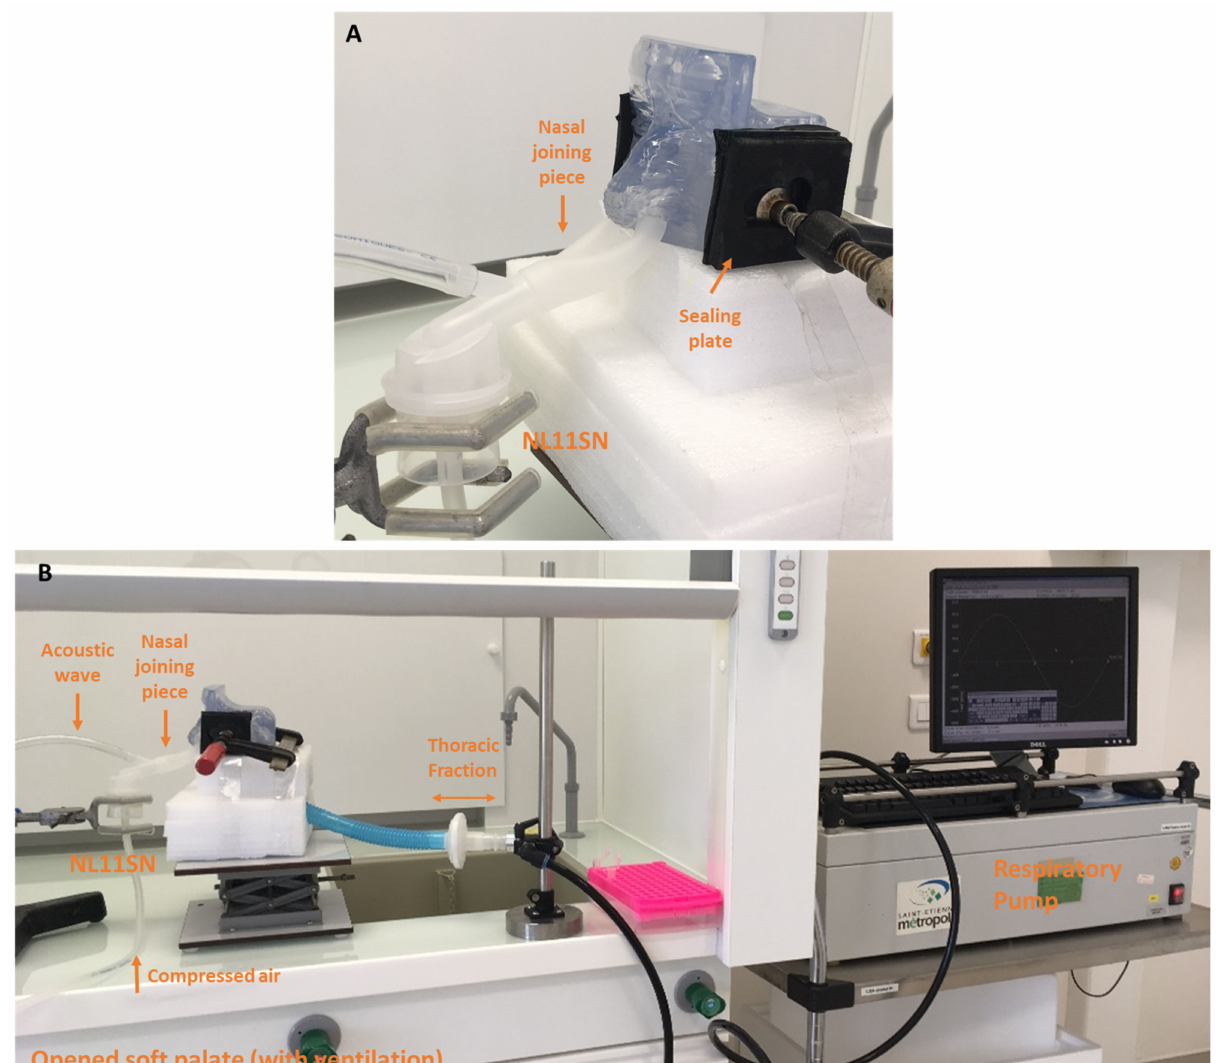
Figure 8. Experimental setup in opened soft palate condition for tobramycin nebulization with the NL11SN device. ( A ) Illustration showing the human nasal cast assembly with sealing of maxillary sinuses and nasal joining piece. ( B ) Illustration showing the human nasal cast assembly with open soft palate connected to the respiratory pump. The thoracic fraction was collected on a PARI filter 41B0523. The nebulization duration was fixed at 10 min with the nasal joining piece. The flow rate value generated by the ATOMISOR compressor was 6.5